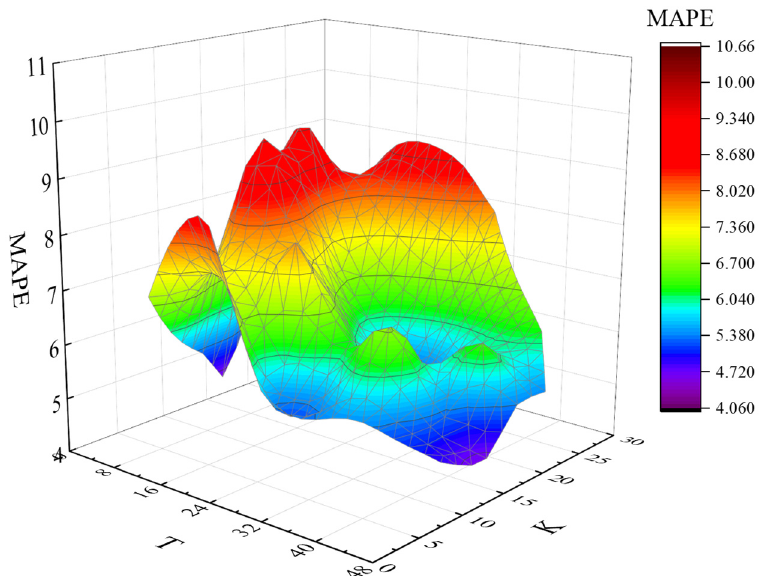
Figure 4. The optimal T value, K value and MAPE (00:00).